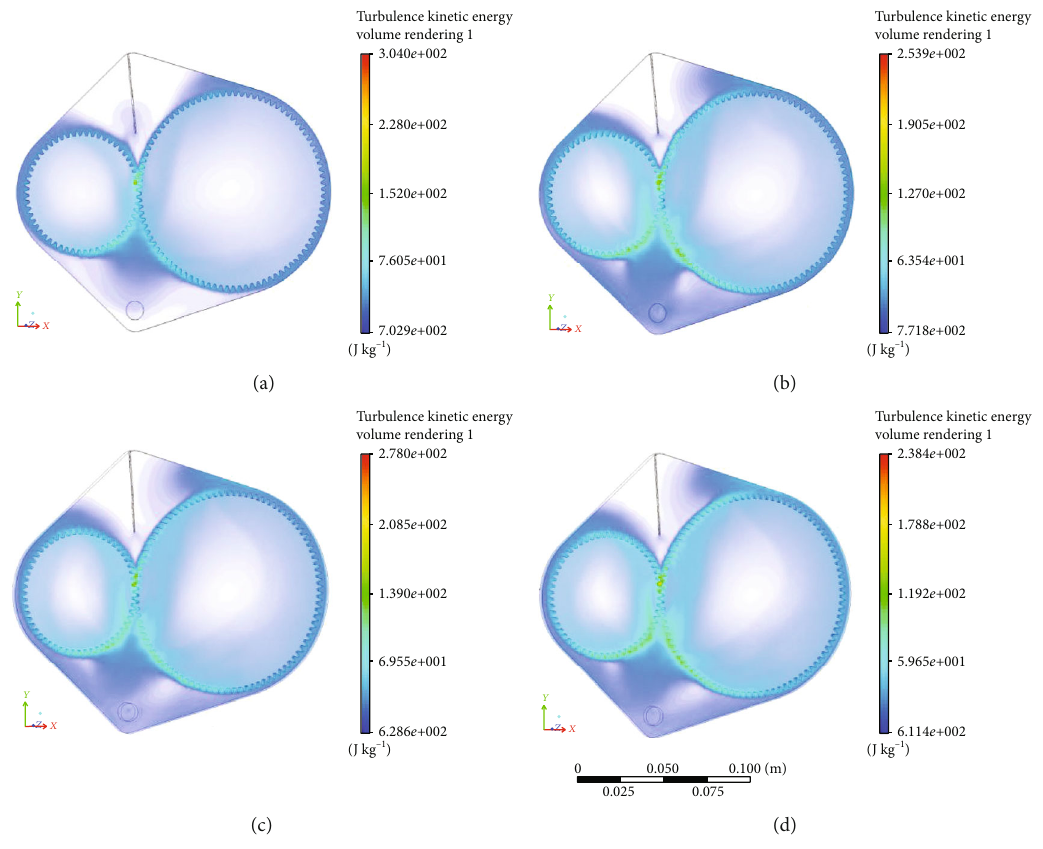
Figure 10: Turbulent kinetic energy of fl ow fi eld in the gearbox: (a) t = 0 : 0074 s , (b) t = 0 : 0116 s , (c) t = 0 : 0167 s , and (d) t = 0 : 0224s .